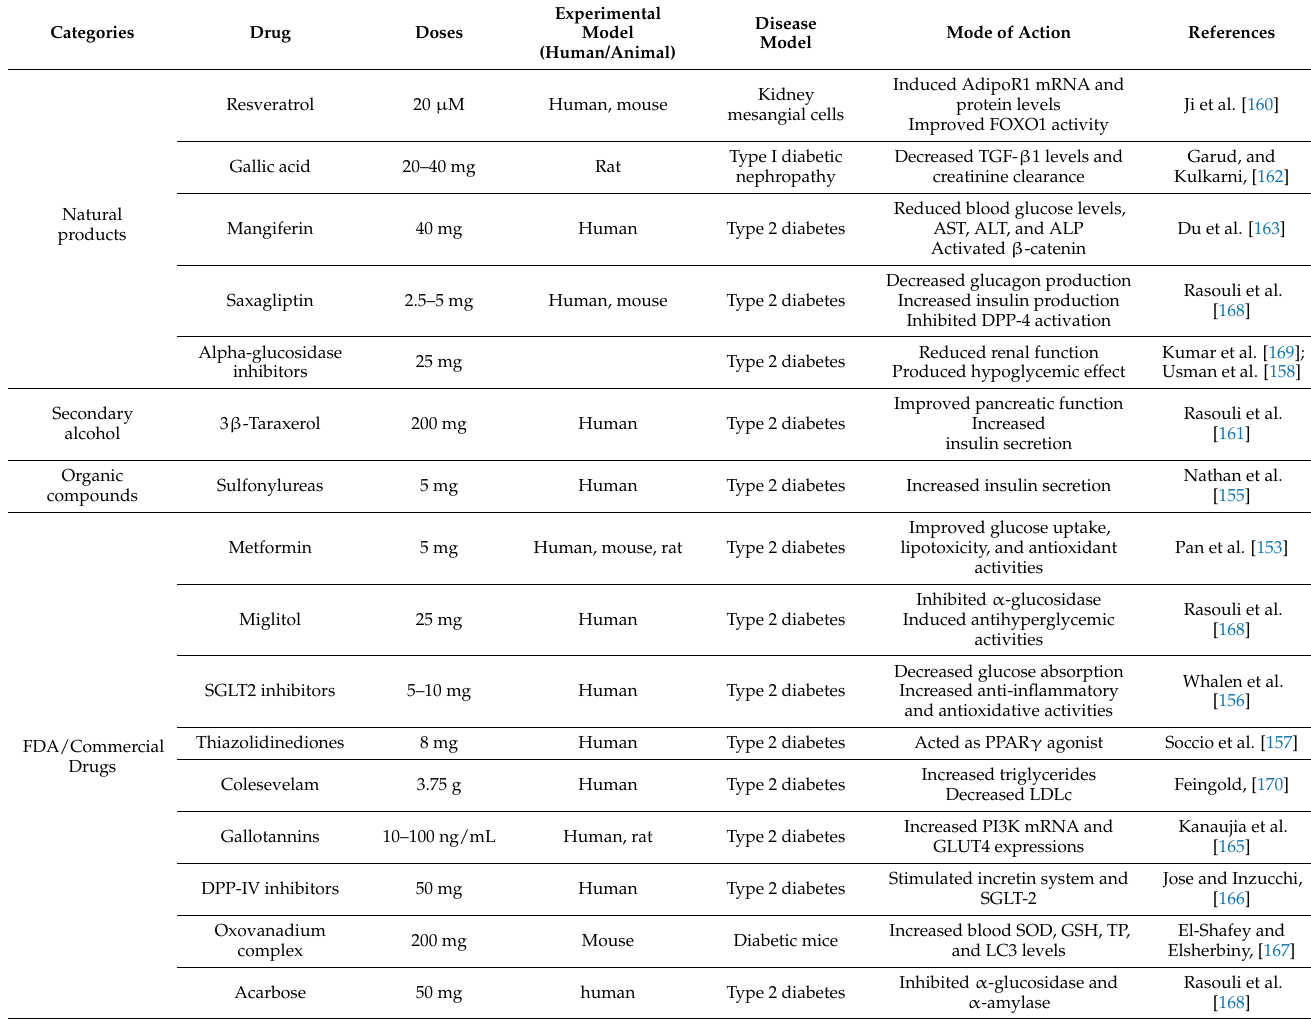
Table 1. Protective effects of insulin signaling activators or insulin-signaling targeted therapies against various diseases.